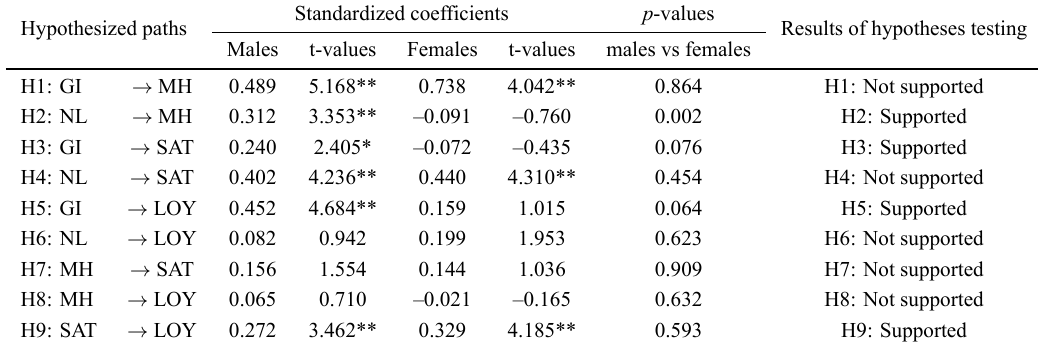
Table 3. The hypotheses testing for the structural model.